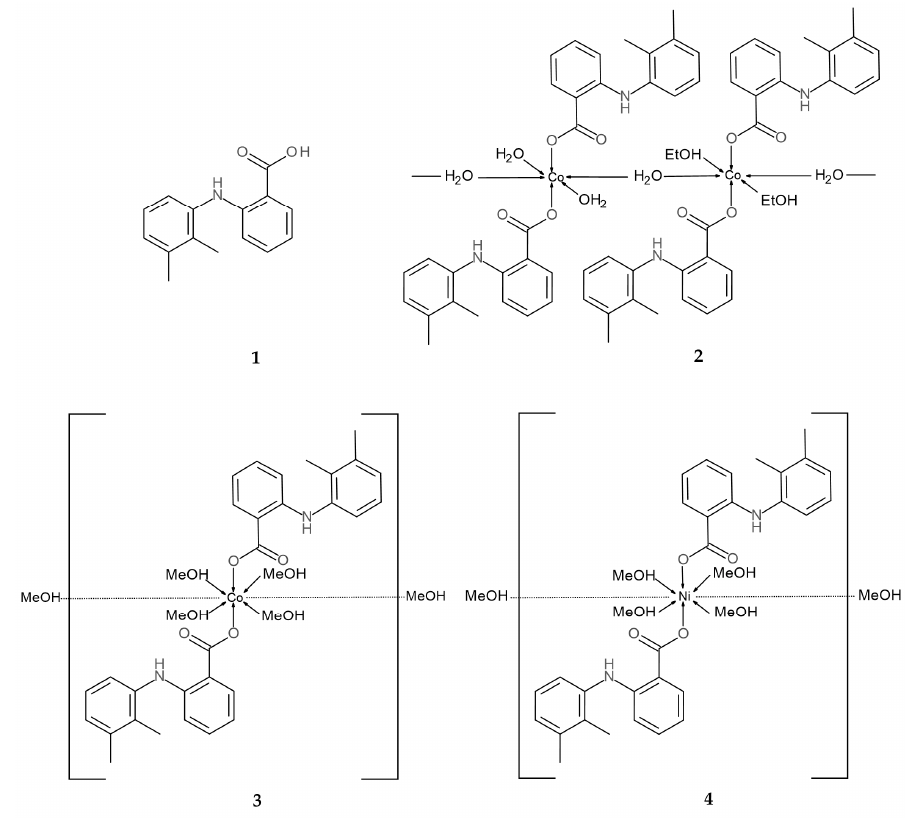
Table 1. Analytical data for 2 – 4 .